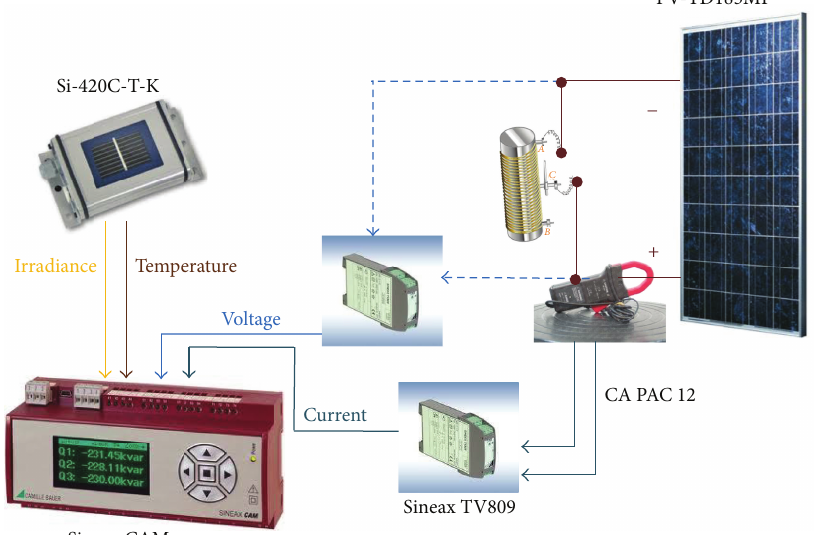
Figure 7: Scheme of measurement elements for data